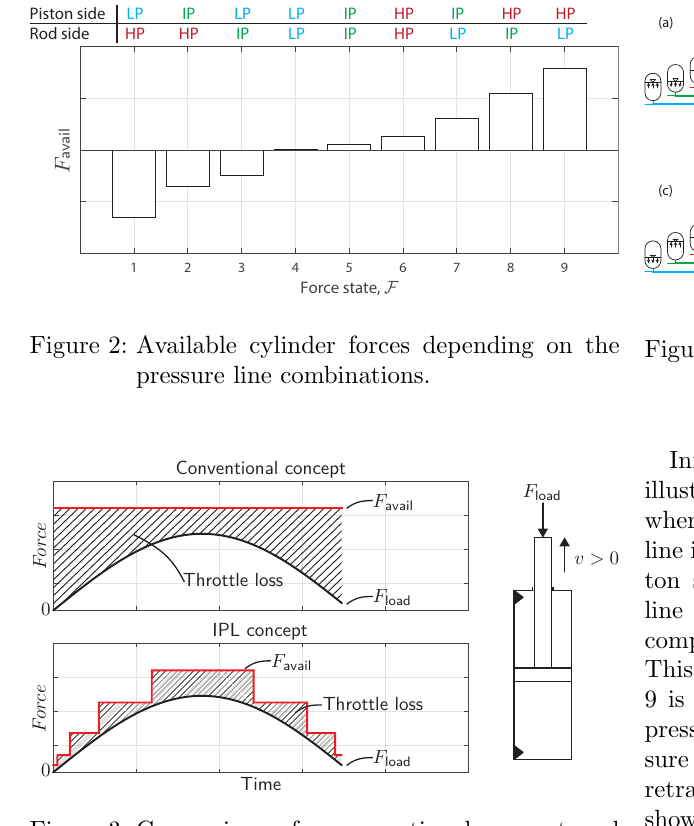
Figure 3: Comparison of a conventional concept and the IPL concept, for an arbitrary operation cycle.